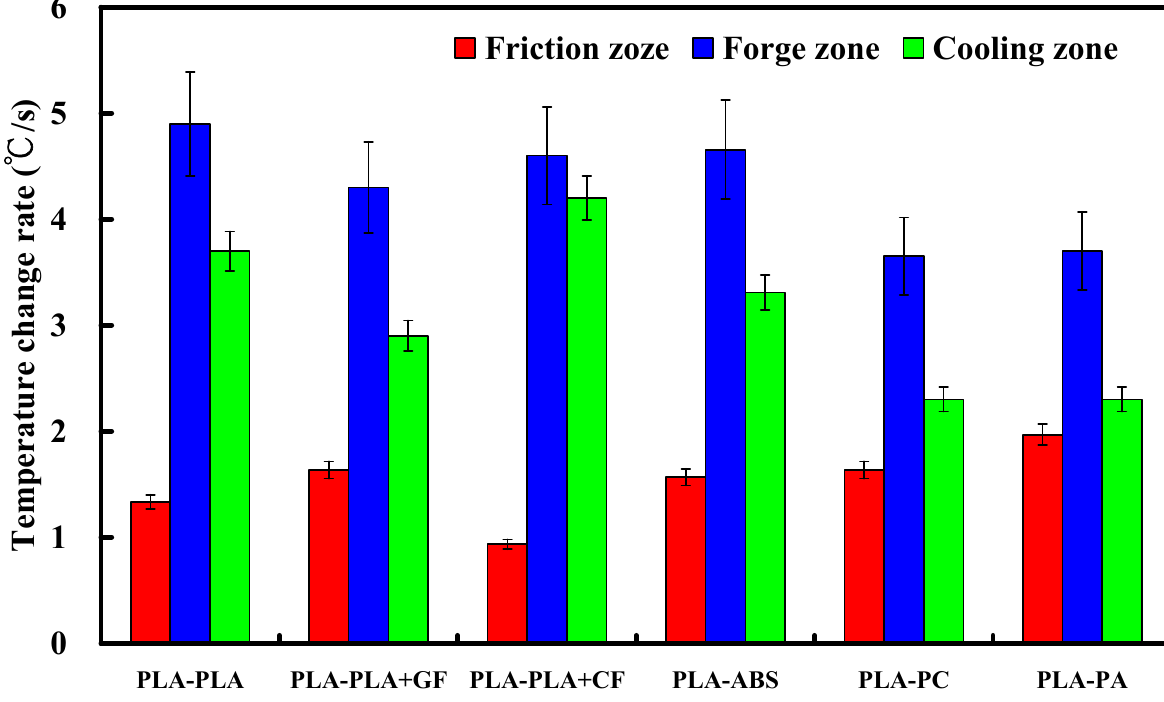
Figure 13. Temperature change rate of three zones in dissimilar joints.